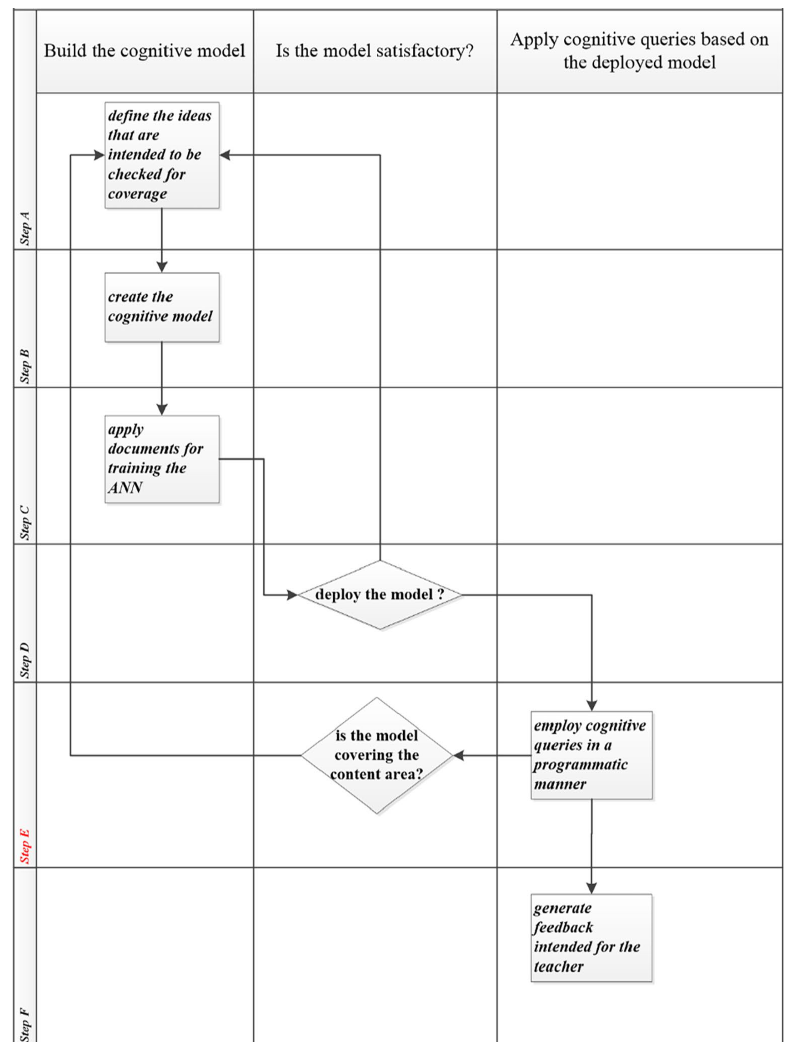
Figure 2. The proposed methodological steps and phases for developing a cognitive